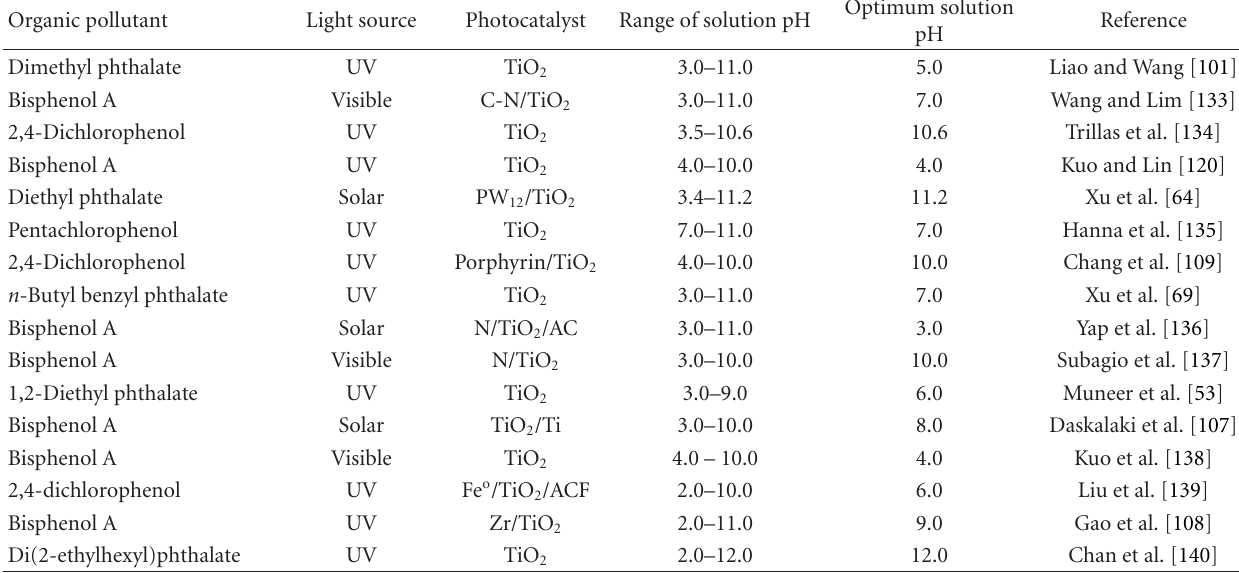
Table 3: E ff ect of solution pH on the photocatalytic degradation of various